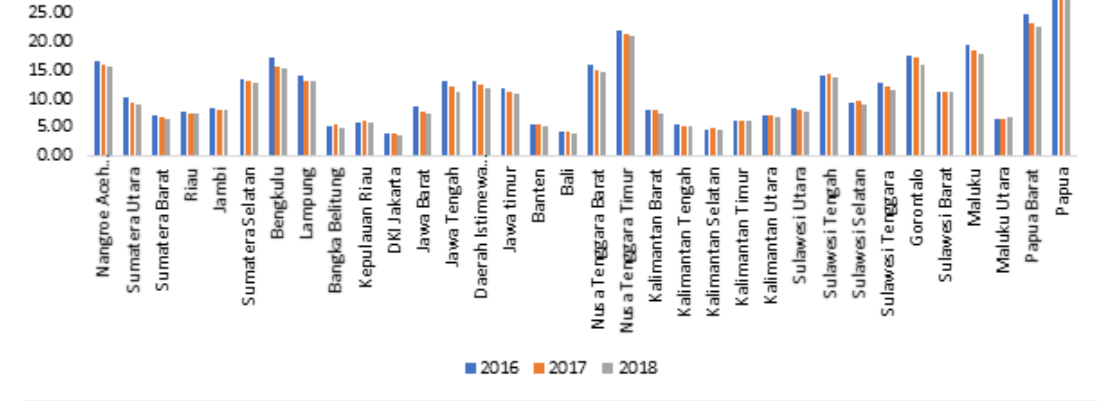
Figure 2: Share of Poor